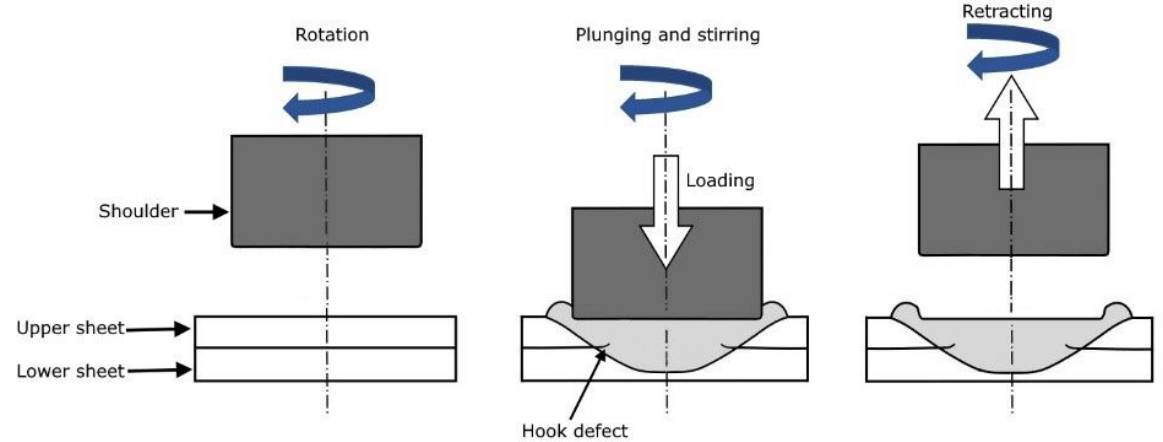
Figure 1: Schematic illustration of pinless friction stir spot welding